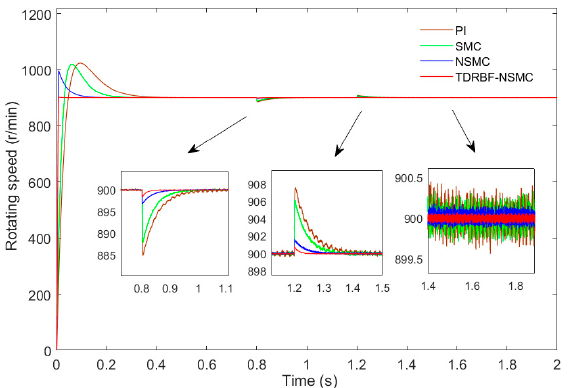
Figure 7. Motor speed curves based on four control methods during sudden load changes.